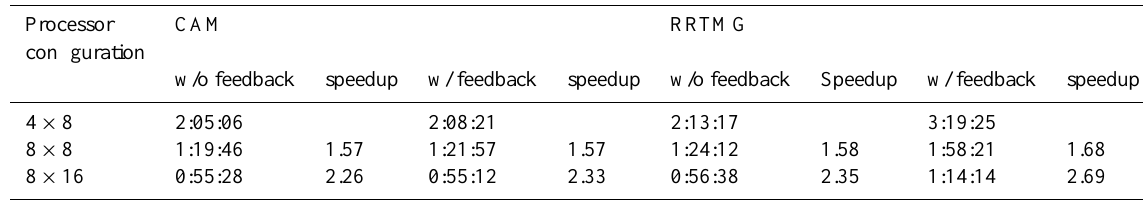
Table 2. Computational performance (hh:mm:ss) and scalability on a linux cluster. Processor CAM RRTMG